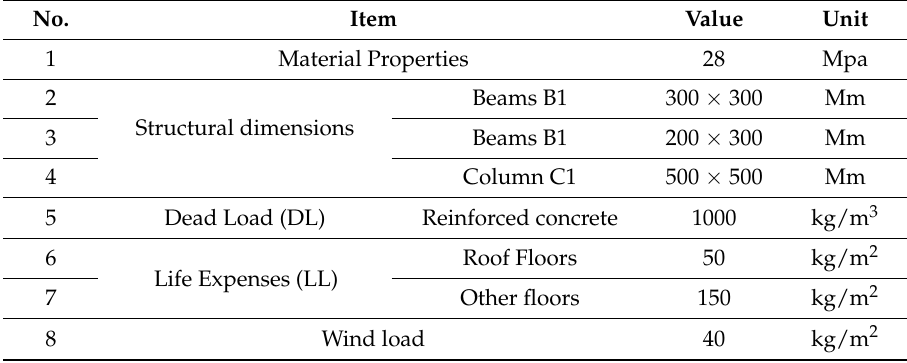
Table 1. Data Input for Structure Modeling in SAP